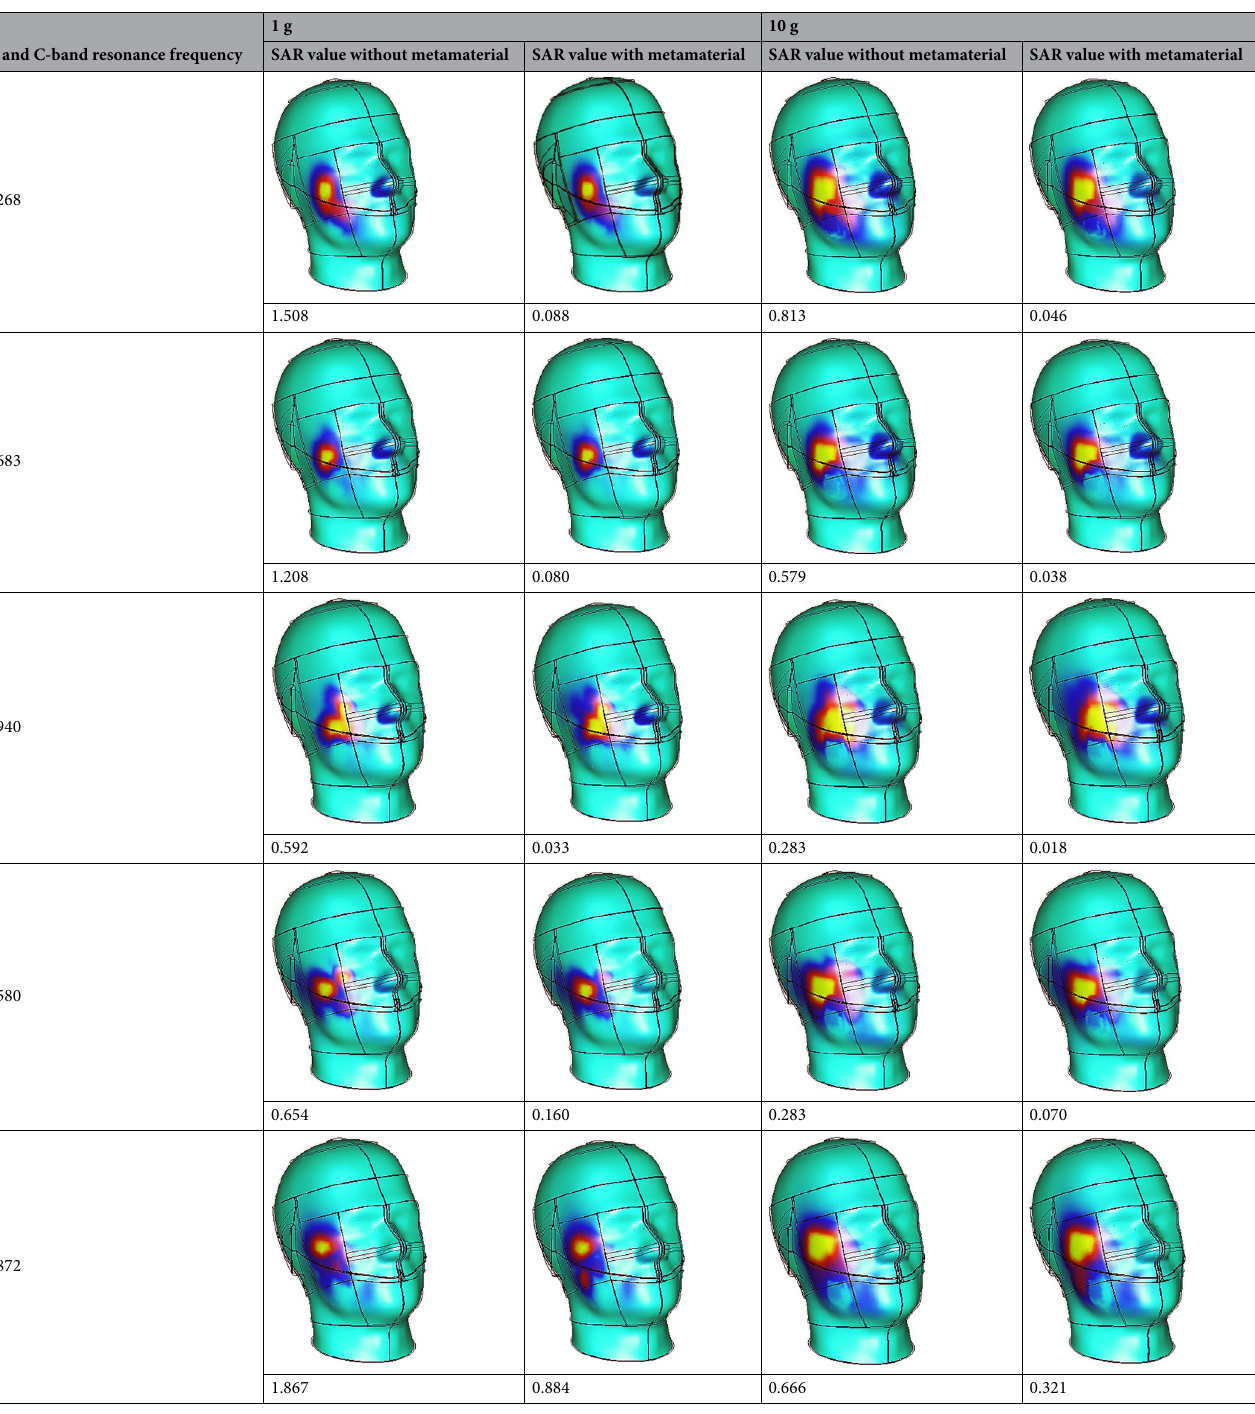
Table 6. SAR values of 1 g and 10 g of tissue volumes without and with the MSM design at S-band and